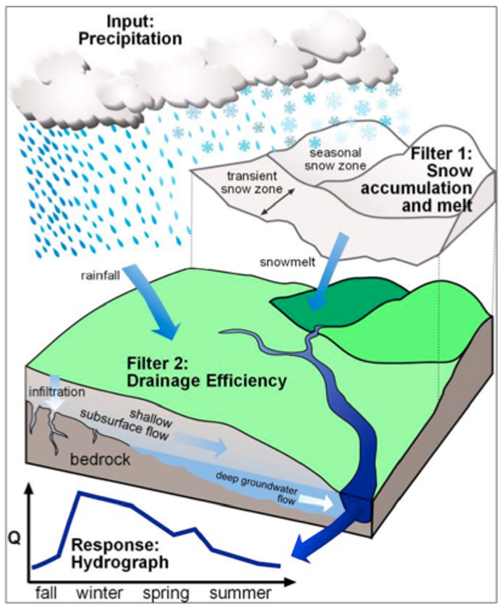
Fig. 1. Landscape responses to precipitation inputs – as a series of filters (Tague and Grant,